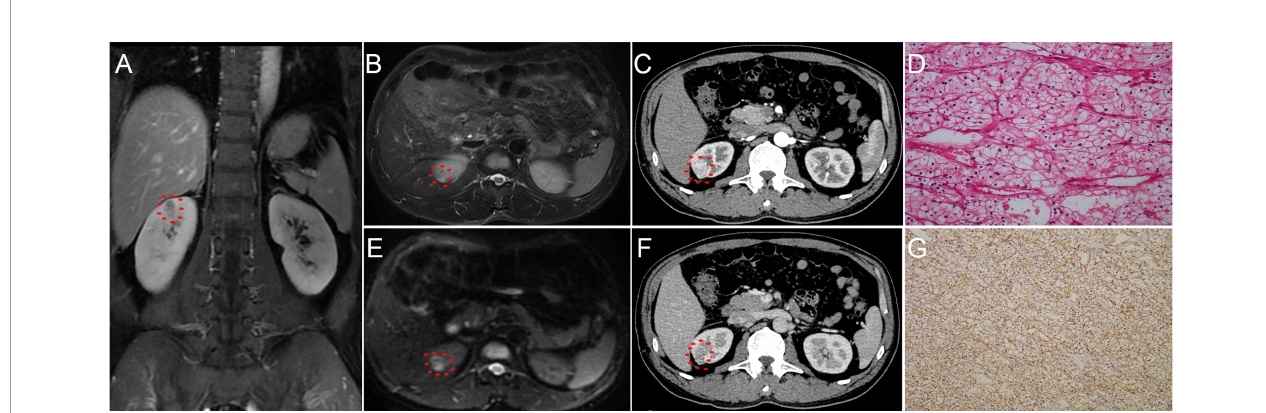
FIGURE 2 | Representative radio-pathological matching case of a clinical T1 renal lesion pathologically upstaged to T3a. Patient summary: a 46-year-old man with a right clinical T1 renal lesion; BMI 25.3 kg/m2; preoperative C-reactive protein 0.2 mg/L; TC 4.37 mmol/L; TG 1.05 mmol/L; HDL-C 1.25 mmol/L; LDL-C 2.86 mmol/ L; CRI-I 3.5; CRI-II 2.3; NLR 2.1; PLR 168.9; LMR 3.7; AGR 1.6; PNI 49.5; lesion dimension on MRI 1.6 cm; R.E.N.A.L. score 7; fi nal pathology: clear cell renal cell carcinoma, Fuhrman grade I, sinus fat invasion. (A) coronal perfusion-weighted MRI; (B) axial T2-weighted MRI; (C, F) dynamic contrast-enhanced CT imaging; (D) representative pathology of partial nephrectomy specimen; (E) axial diffusion-weighted MRI with b value set at 600 s/mm2; (G) immunohistochemical staining fi gure regarding the positive expression of carbonic anhydrase IX.